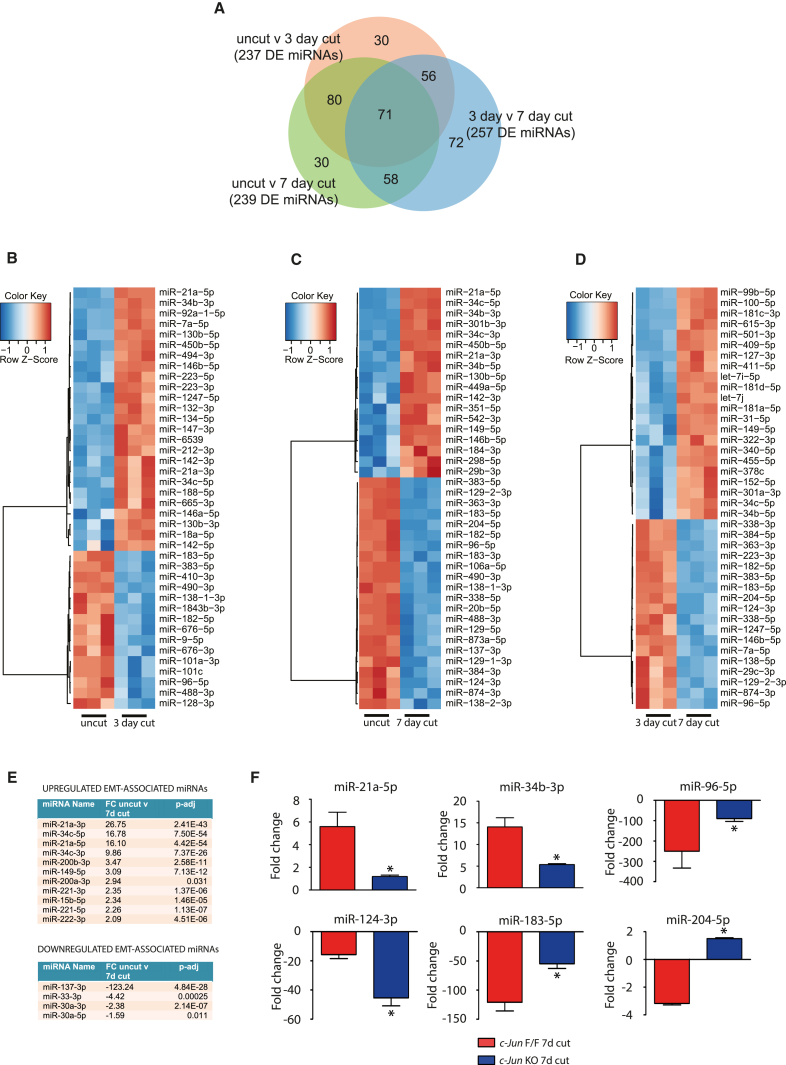
miRNA Expression after Nerve Injury(A) Venn diagram showing the overlap of DE miRNAs between uncut, 3-day cut, and 7-day cut sciatic nerve.(B–D) Heatmap of the top 40 DE miRNAs between (B) uncut and 3-day cut nerves, (C) uncut and 7-day cut nerves, and (D) 3-day cut and 7-day cut nerves (n = 5, p-adj < 0.05).(E) Enrichment analysis of EMT associated miRNAs from small RNA-seq study showing the most upregulated and downregulated miRNAs (FC, Fold change; p-adj < 0.05).(F) Expression of miRNAs in c-Jun flox/flox (control; red) and c-Jun null (P0Cre c-Jun flox/flox; blue) 7-day cut nerves. ∗p < 0.05, n = 3. Fold change is relative to the uncut control nerve (c-Jun flox/flox). Error bars represent SEM.